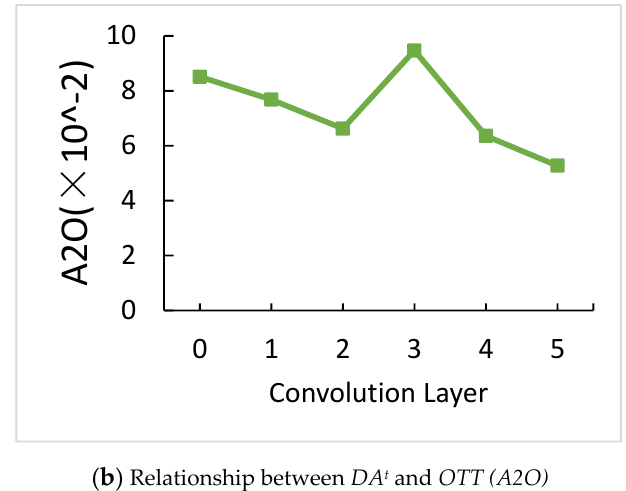
Figure 9. Comparison of the number of convolution layers.